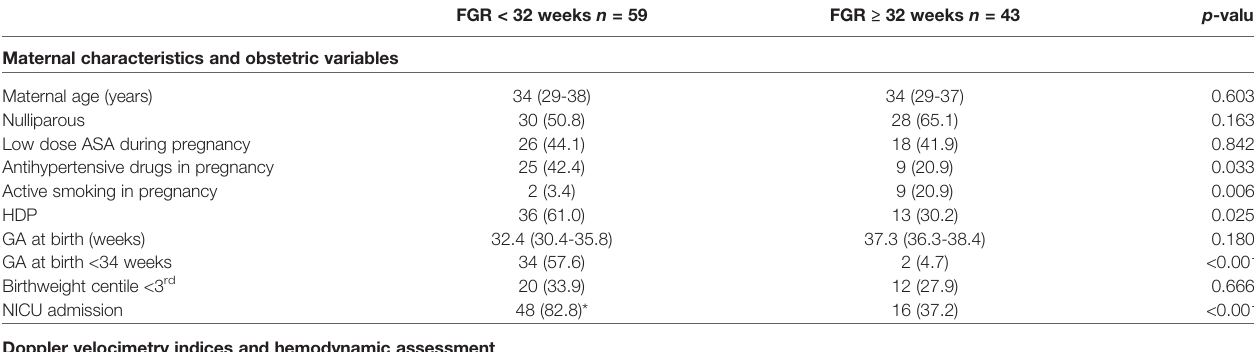
TABLE 2 | Demographic, obstetric, and maternal hemodynamic data of early- versus late-onset FGR. FGR < 32 weeks n = 59 FGR ≥ 32 weeks n = 43 p -value Maternal characteristics and obstetric variables